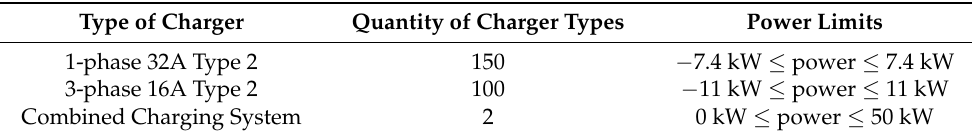
Table 2. Types of EV chargers, quantity of them and their power